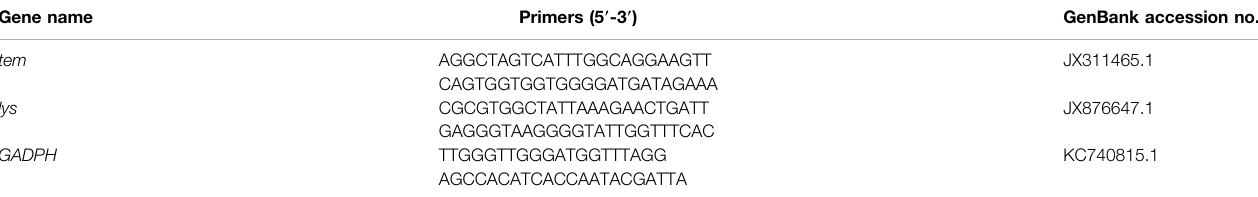
TABLE 1 | The primers were used for quantitative real-time PCR. tem , lys, and GADPH symbolize the genes of termicin, lysozyme, and glyceraldehyde-3-phosphate dehydrogenase (reference gene),